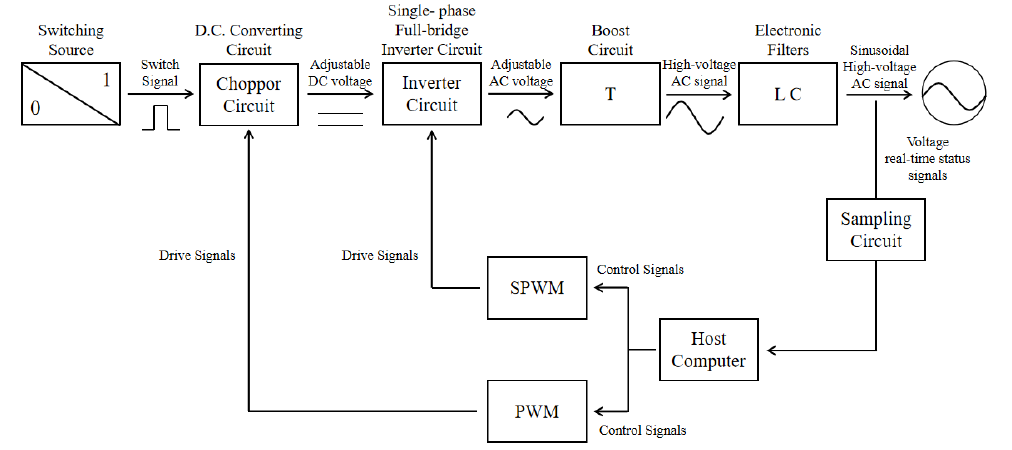
Figure 2. Design of the sinusoidal high-voltage AC power system.